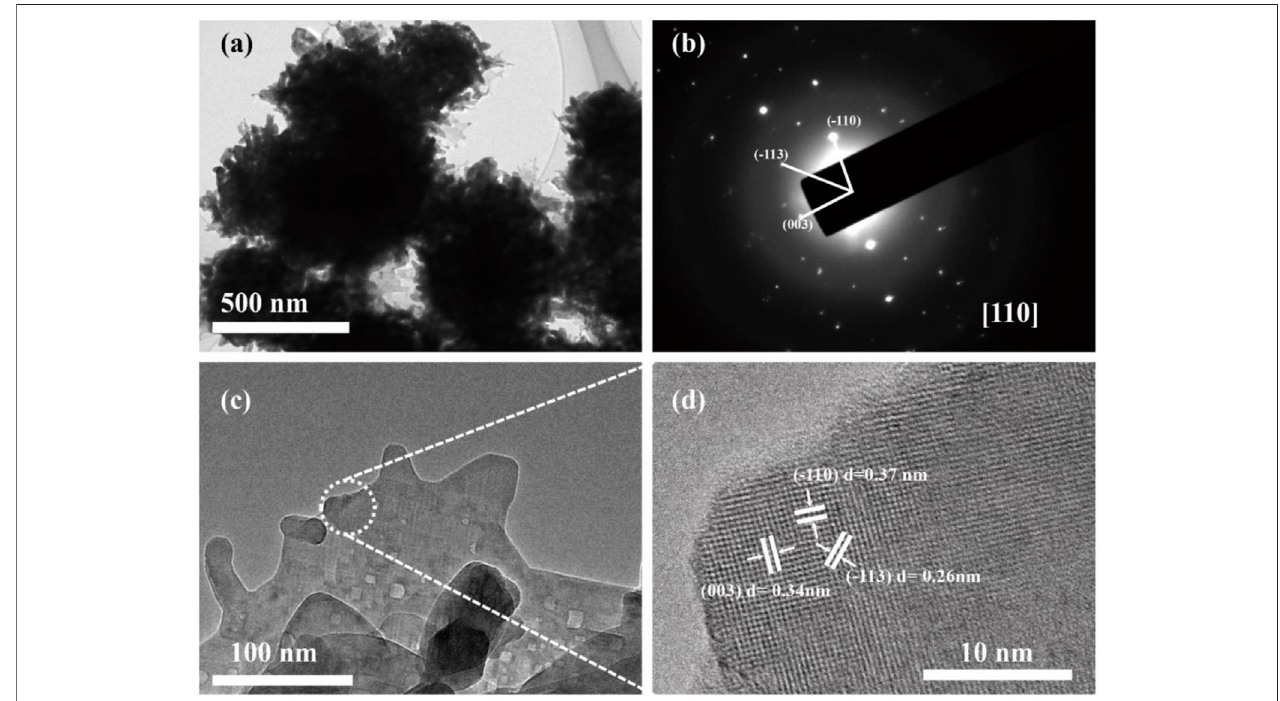
FIGURE 4 | (A) TEM image of pristine TNO; (B) SAED pattern of pristine TNO; (C) enlarged magni fi cation TEM image of pristine TNO; (D) HRTEM image of pristine